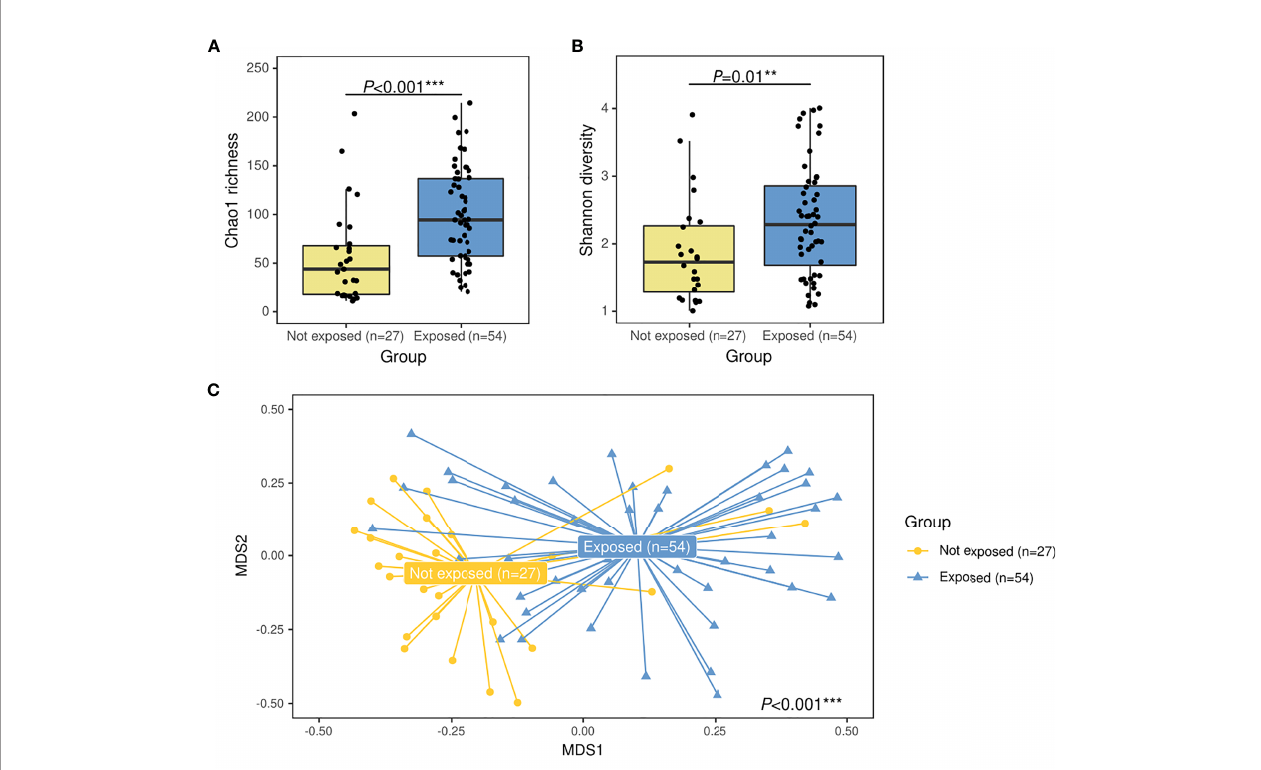
FIGURE 1 | Alpha- and beta-diversity comparisons between patients with IPD not exposed to antibiotics before sample collection (yellow) and IPD patients with previous antibiotic exposure (blue). Boxplots showing the Chao1 richness (A) and Shannon diversity indexes (B) according to antibiotic-exposure groups at the ASV level. Differences by group were assessed with simple linear regression analyses including confounding variables as copredictors (age, gender, seasonality, vaccination, ICU admission, and length of hospital stay). Three observations from the exposed group were deleted due to missing values in vaccination variable. (C) Nonmetric multidimensional scaling (NMDS) plot based on Bray – Curtis dissimilarities of nasopharyngeal microbiota composition of samples from all patients included in the study. Samples of each group are connected with their corresponding centroids using the function “ ordispider ” (Vegan R package). P-value corresponds to Adonis PERMANOVA test on the antibiotic- exposure group variable and including confounding variables as covariates. Signi fi cance codes: *** ≤ 0.001; ** ≤ 0.01; * ≤ 0.05. MDS, nonmetric multidimensional